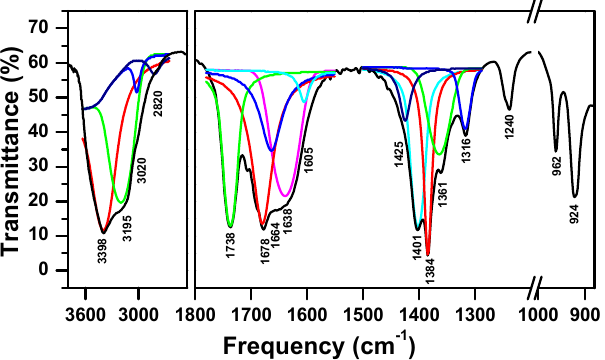
Figure 2. Fourier transform infrared spectrum of the synthesized complex from a mixture of nickel nitrate Ni(NO 3 ) 2 ·6H 2 O, ammonium molybdate (NH 4 ) 6 Mo 7 O 24 ·4H 2 O, and oxalic acid H 2 C 2 O 4 ·2H 2 O at 160 ° C.